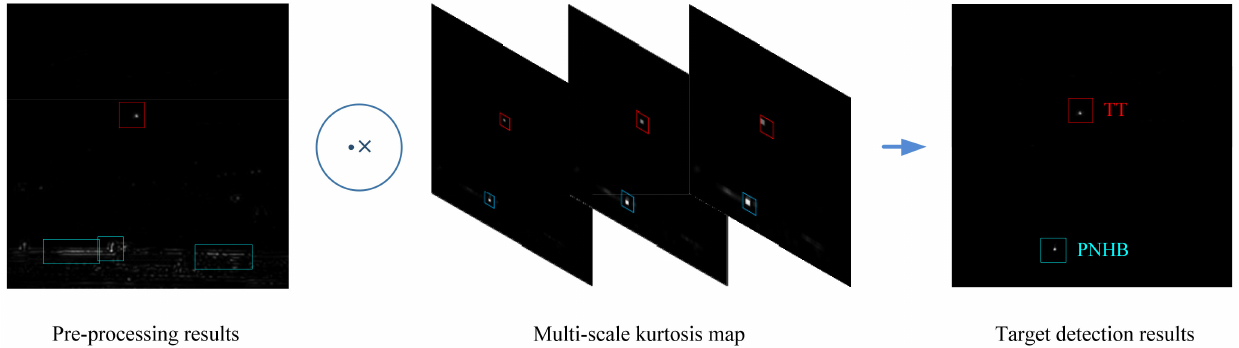
Figure 5. The frame of multiscale kurtosis